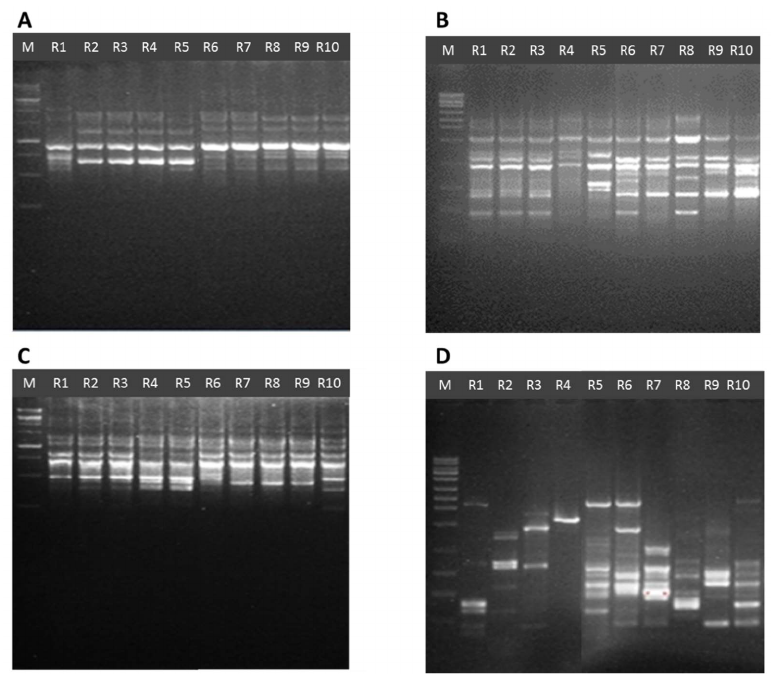
Figure 3. Representative inter simple sequence repeat (ISSR) profiles in 11 Pleurotus Jordanian isolates from the Tell ar-Rumman location. ( A ) UBC866; ( B ) UBC864; ( C ) UBC809; ( D ) UBC823; M: 1 Kb Ladder (Gene Direx, Keelung City, Taiwan). Table 3. ISSR markers analysis and polymorphism in 19 Jordanian Pleurotus isolates.